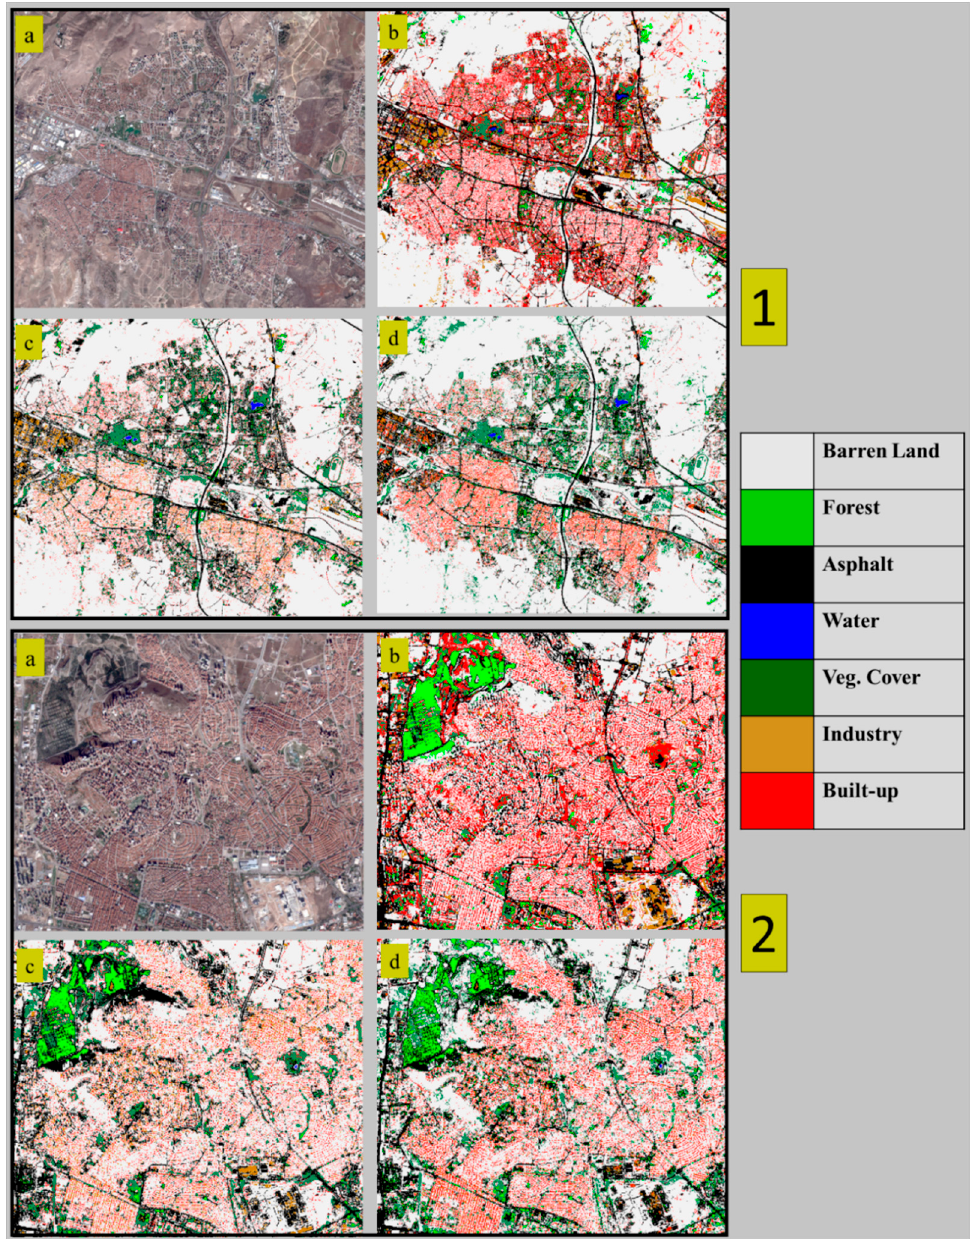
Figure 11. ( a ) RGB image of Ankara from Sentinel-2A, ( b ) the classified Sentinel-2A, ( c ) the classified multi-index (NDBI, NDVIre, and MNDWI) and ( d ) the classified multi-index (NDTI, NDVIre, and MNDWI) images. Table 6. Classification accuracies of the different approaches for the Ankara region. Table 8. Classification accuracies of different approaches for the Konya region. (Sentinel-2A Image (10 Bands)) (Sentinel-2A image (10 Bands))